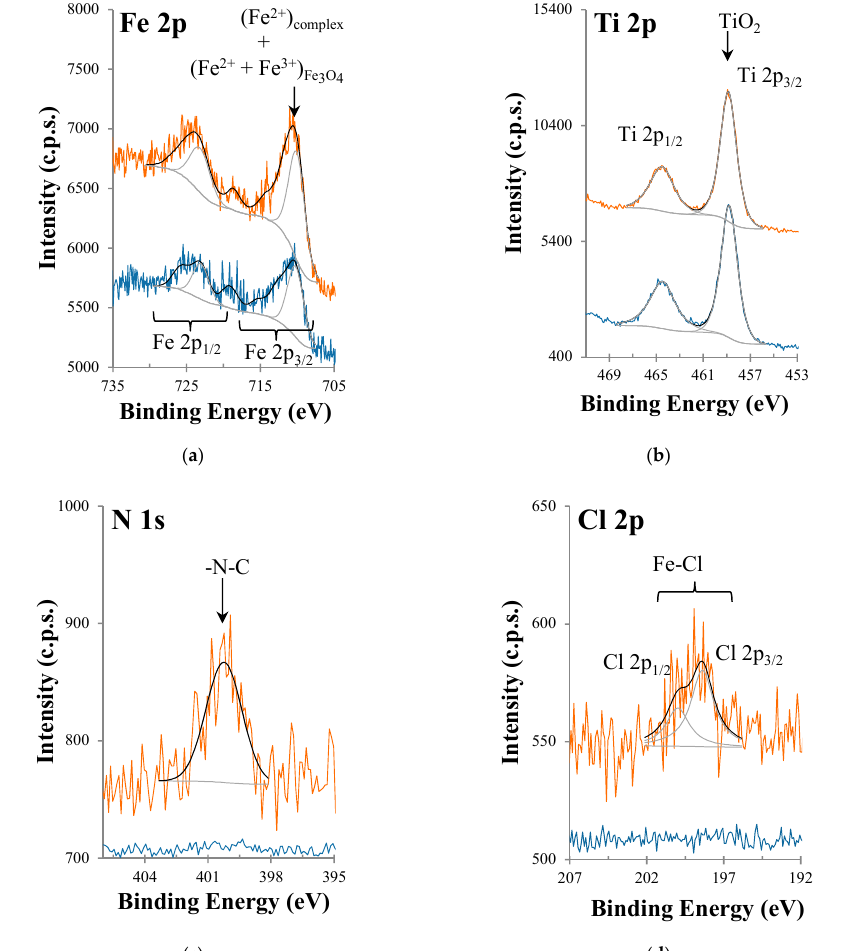
Figure 3. X-ray Photoelectron spectroscopy (XPS) regions: ( a ) Fe 2p; ( b ) Ti 2p; ( c ) N 1s; ( d ) Cl 2p of Fe 3 O 4 / TiO 2 (bottom) and Fe 3 O 4 / TiO 2 / [FeCl 2 { κ 3 -HC(pz) 3 }]